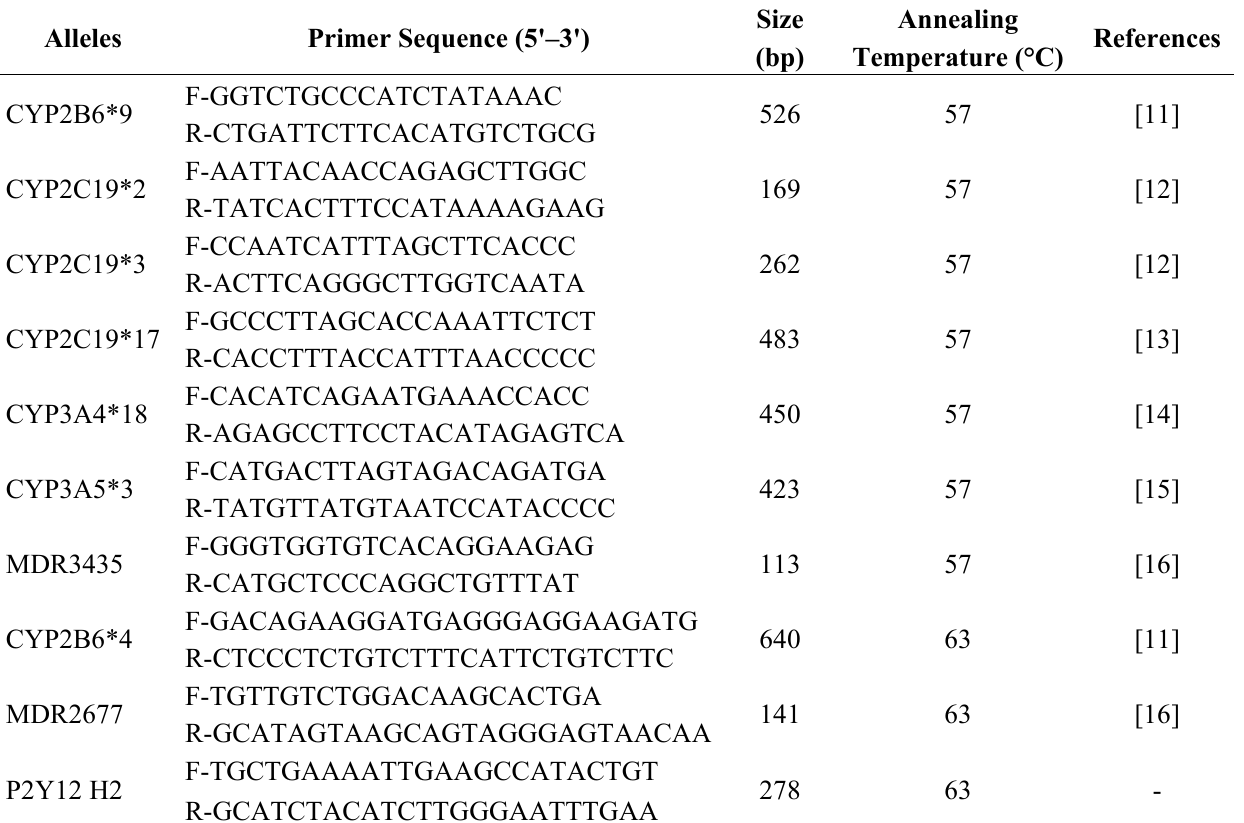
Table 1. List of primers used in multiplex